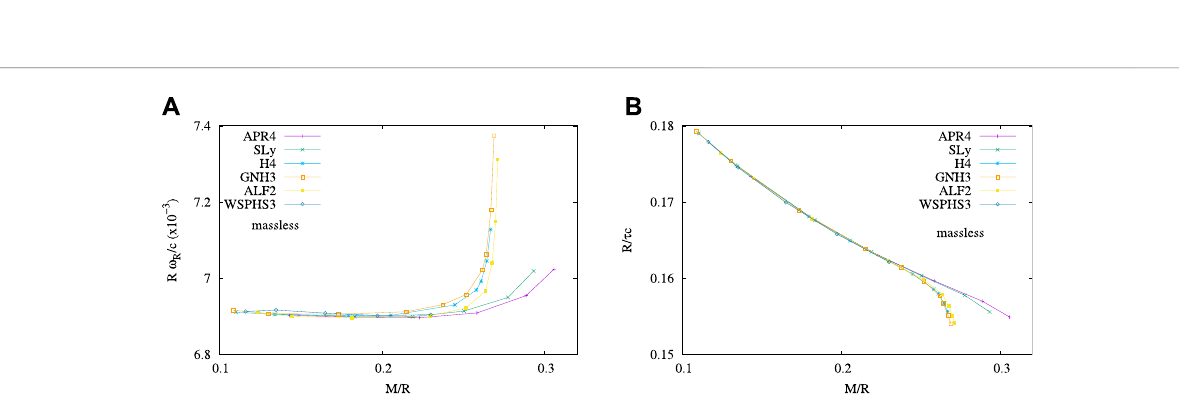
FIGURE 12 Scaled radial ϕ -modes for the massless scalar – tensor theory: dimensionless frequency R ω R / c versus compactness C = M / R (A) and dimensionless inverse damping time R /( c τ ) versus compactness C (B) . The colors indicate the different equations of